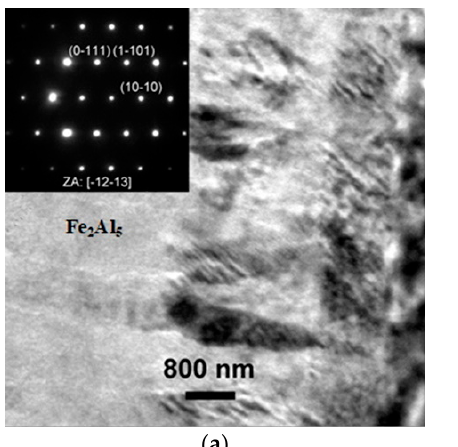
Figure 9. TEM micrograph of the first coating sublayer directly in contact with the martensite structure of the hardened 22MnB5 steel. Inset is the indexed CB-SAEDP, revealing the crystallo- graphic nature of this thin sublayer identified as Fe 3 (Al,Si)C.